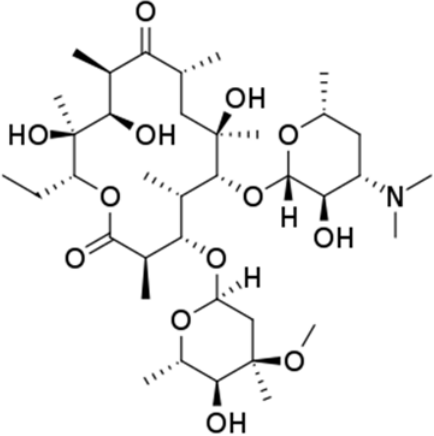
Figure 1. Chemical structure of erythromycin.